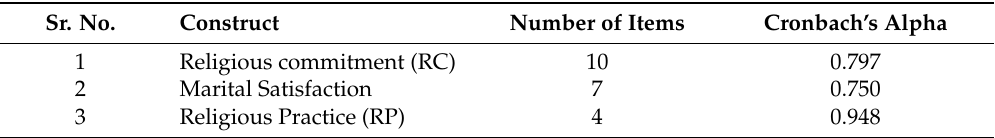
Table 1. Reliability of variables [57].